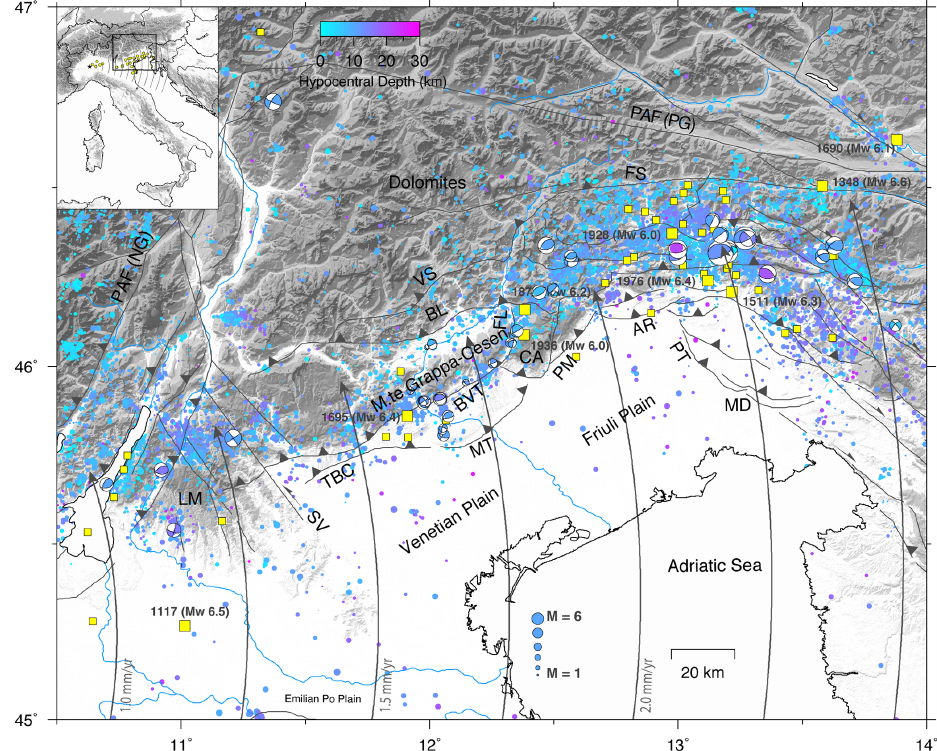
Figure 1. Seismotectonic map of the study area with the major tectonic lineaments shown in black (from Serpelloni et al., 2016). LM: Lessini Mountains; SV: Schio–Vicenza line; TBC: Thiene–Bassano–Cornuda thrust; MT: Montello thrust; BVT: Bassano–Valdobbiadene thrust; BL: Belluno thrust; VS: Valsugana thrust; CA: Cansiglio plateau; PM: Polcenigo–Maniago thrust; AR: Araba–Ragona thrust; PT: Pozzuolo thrust; MD: Medea thrust; FS: Fella–Sava line; PAF (PG): Periadriatic fault and Pusteria–Gailtal line. Major historical events ( M w > 5 are the small squares and M w > 6 are the greater squares) from the parametric catalogue of Italian earthquakes (CPTI) (Rovida et al., 2016) are shown as yellow squares. The blue–purple symbols show instrumental seismicity for the 2000–2017 time span extracted from the National Institute of Oceanography and Applied Geophysics (OGS) bulletins (http://www.crs.inogs.it/bollettino/RSFVG, last access: 31 August 2020). The focal mechanisms (from Anselmi et al., 2011; Danesi et al., 2015; Serpelloni et al., 2016) are plotted with the same color palette of the OGS instrumental seismicity. The small circles around the geodetic pole of rotation show the motion direction of Adria relative to Eurasia (Serpelloni et al., 2016). Insert map: location of the Euler rotation pole (star), the global navigation satellite system (GNSS) stations (yellow dots) used to define the Adria rotation pole in Serpelloni et al. (2016) and small circles of the Adria–Eurasia rotation pole with respect to the region of interest (black